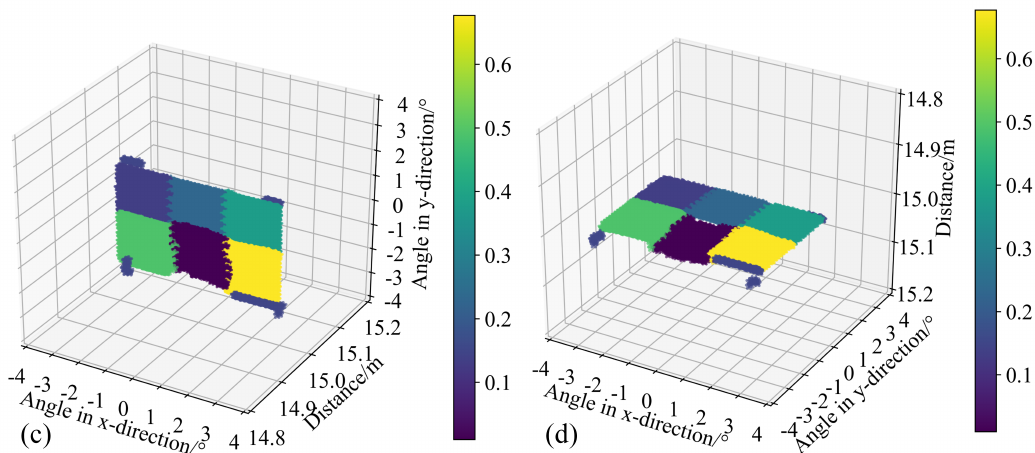
Figure 8. The scanning target and its point clouds. ( a ) The scanning target, ( b ) point cloud without intensity data, and ( c , d ) the distance–intensity point clouds of the